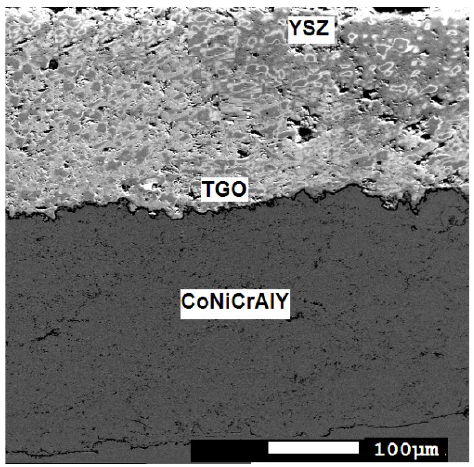
Figure 1. Thermal barrier coating (TBC)